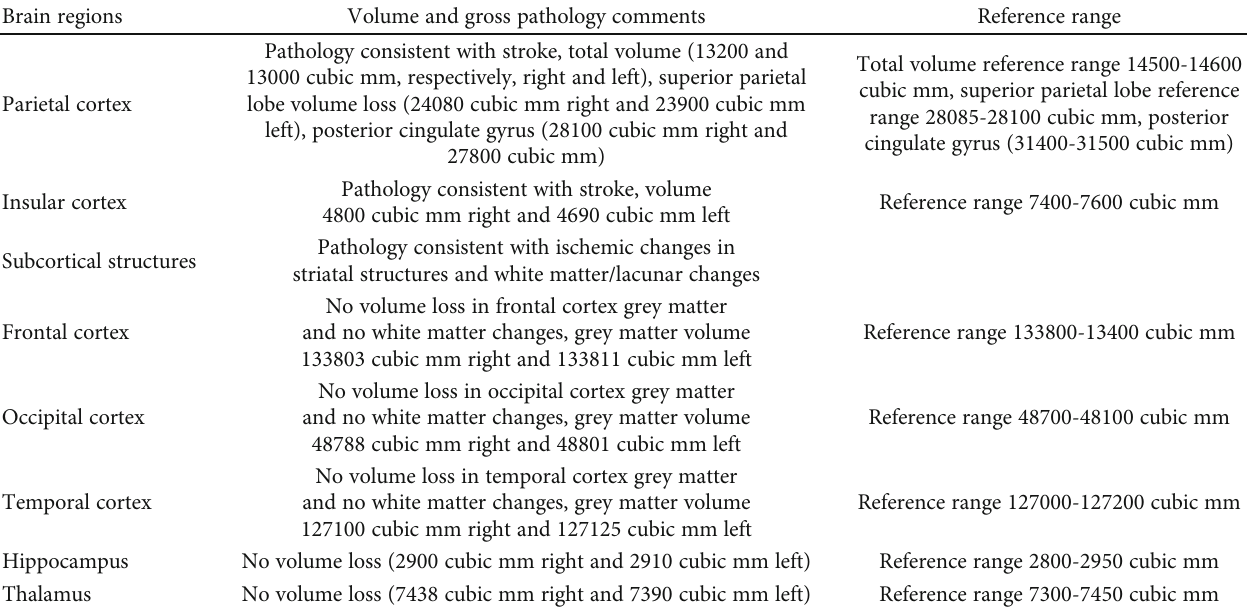
Table 3: Gross pathology and volumetric characteristics of the di ff erent brain regions of the patient on MRI. Brain